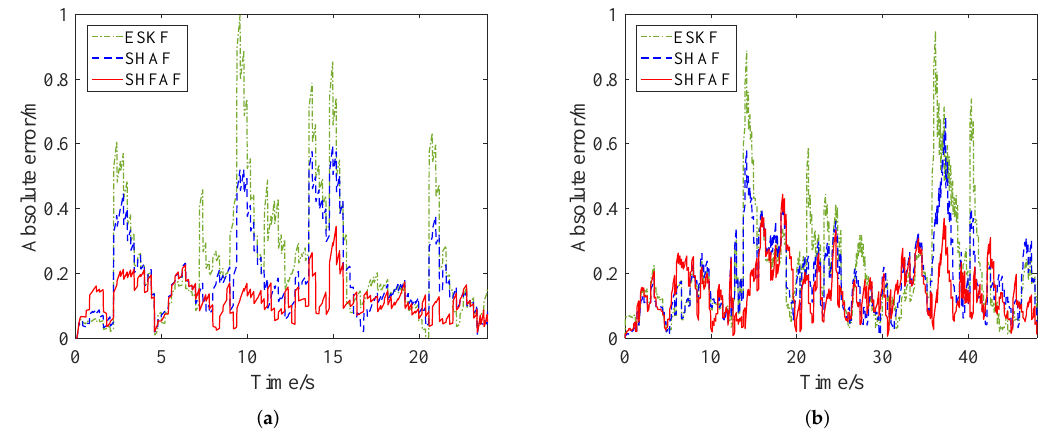
Figure 14. The absolute positioning errors. ( a ) Trajectory A. ( b ) Trajectory